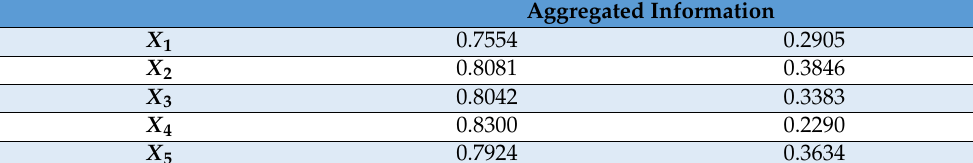
Table 12. Collective preference information.